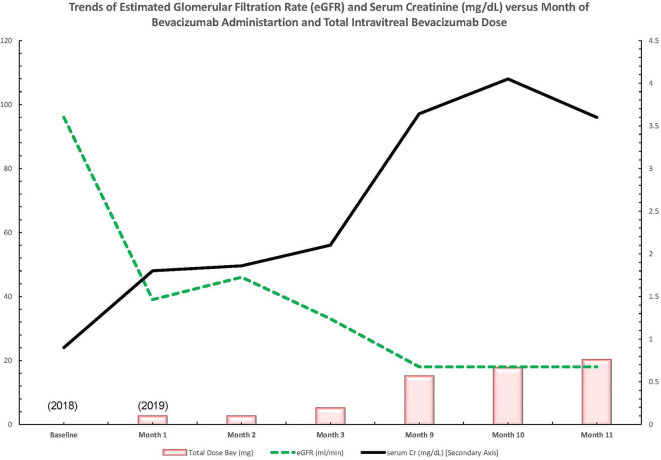
Trend of lab values over time in a patient with diabetic retinopathy treated with bevacizumab and subsequent thrombotic microangiopathy. Bev, bevacizumab; Cr, creatinine; dl, deciliter; eGFR, estimated glomerular filtration rate; mg, milligram; ml, milliliter; min, minute.